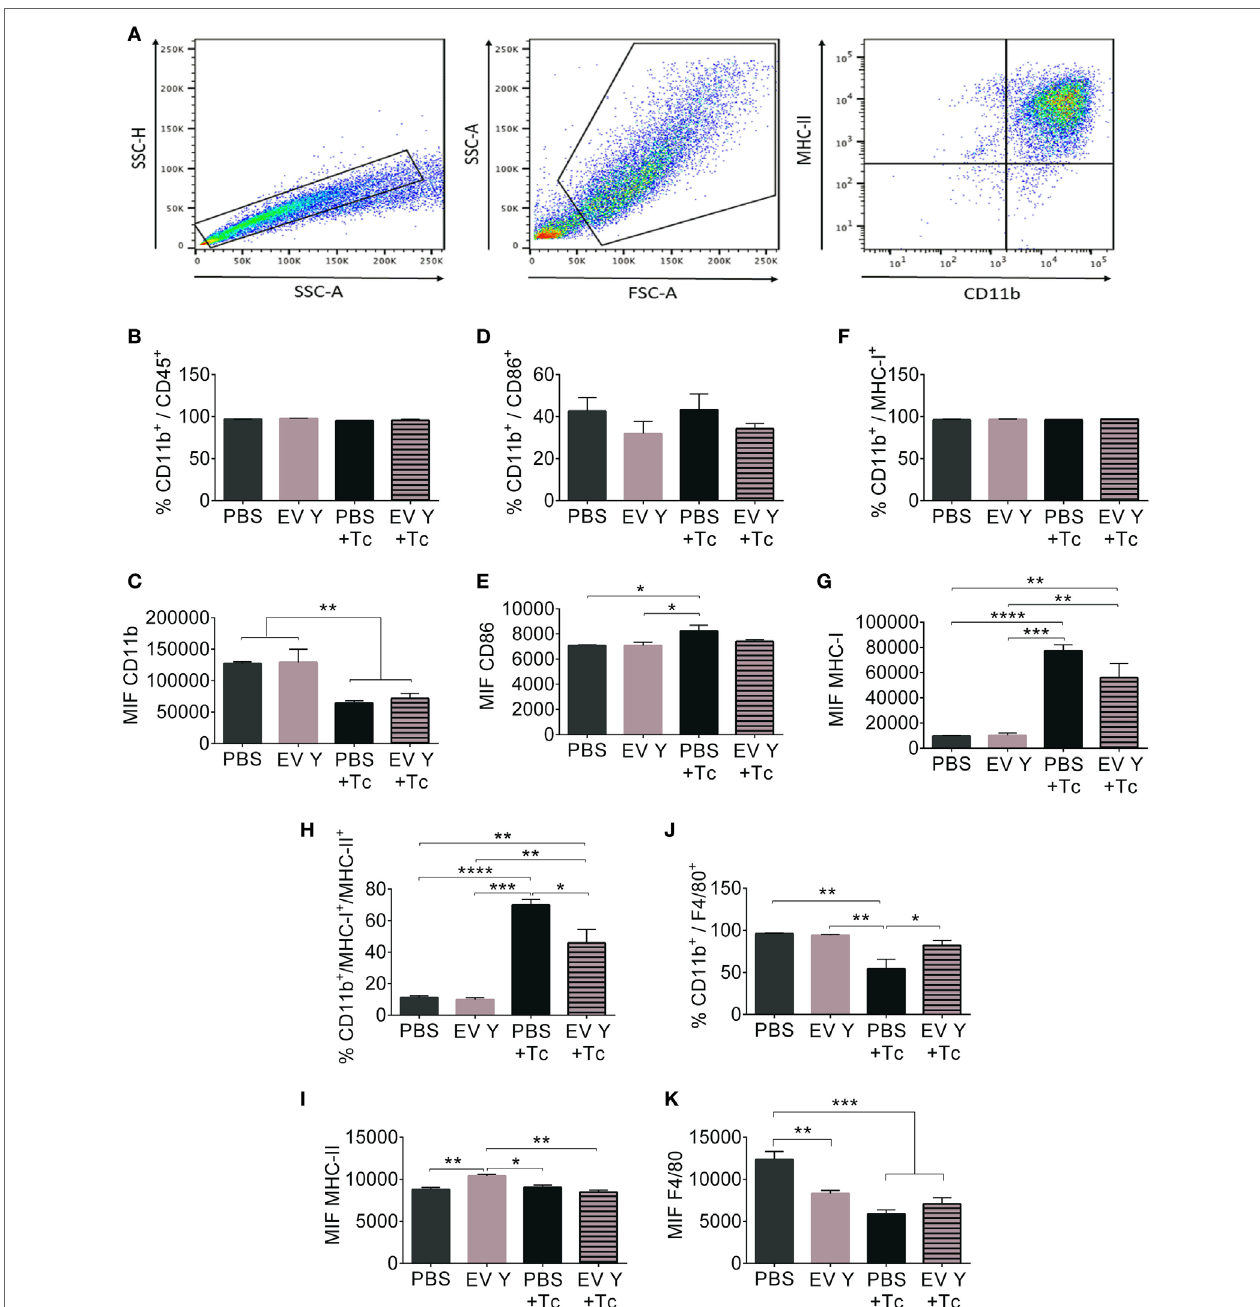
FigUre 5 | Previous inoculation of Trypanosoma cruzi extracellular vesicles (EVs) alters the expression and frequency of surface activation molecules in macrophages harvested from infected-mouse peritoneum. C57BL/6 mice were inoculated with extracellular vesicles derived from T. cruzi Y (EV Y) (i.p.). One week later, the mice were infected with T. cruzi by the same route or were inoculated with EV Y only. Infected, uninfected, and PBS-inoculated mice were used as controls. On day 7 after T. cruzi infection and on day 7 after EV Y inoculation in uninfected animals, peritoneum cells were harvested and analyzed by flow cytometry. (a) Gate strategy definition, (B,c) and the cells positive for the molecule CD11b were immunophenotyped for the frequency (%) and expression levels (median intensity of fluorescence (MIF)) of surface molecules (D,e) CD86, (F,g) MHC-I, (h,i) MHC-I/MHC-II, and (J,K) F4/80. The results are expressed as the mean ± standard error from 4 to 7 mice per group in an experiment representative of two similar experiments. * P < 0.05; ** P < 0.01 significantly different (one-way ANOVA with Tukey’s post-test)—Graph Pad